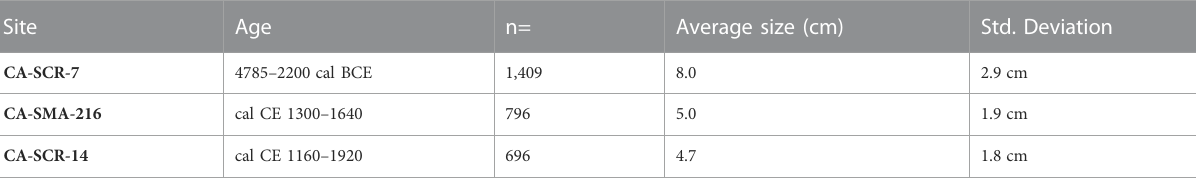
TABLE 4 Estimated average sizes of mussels from the Año Nuevo and Wilder Ranch